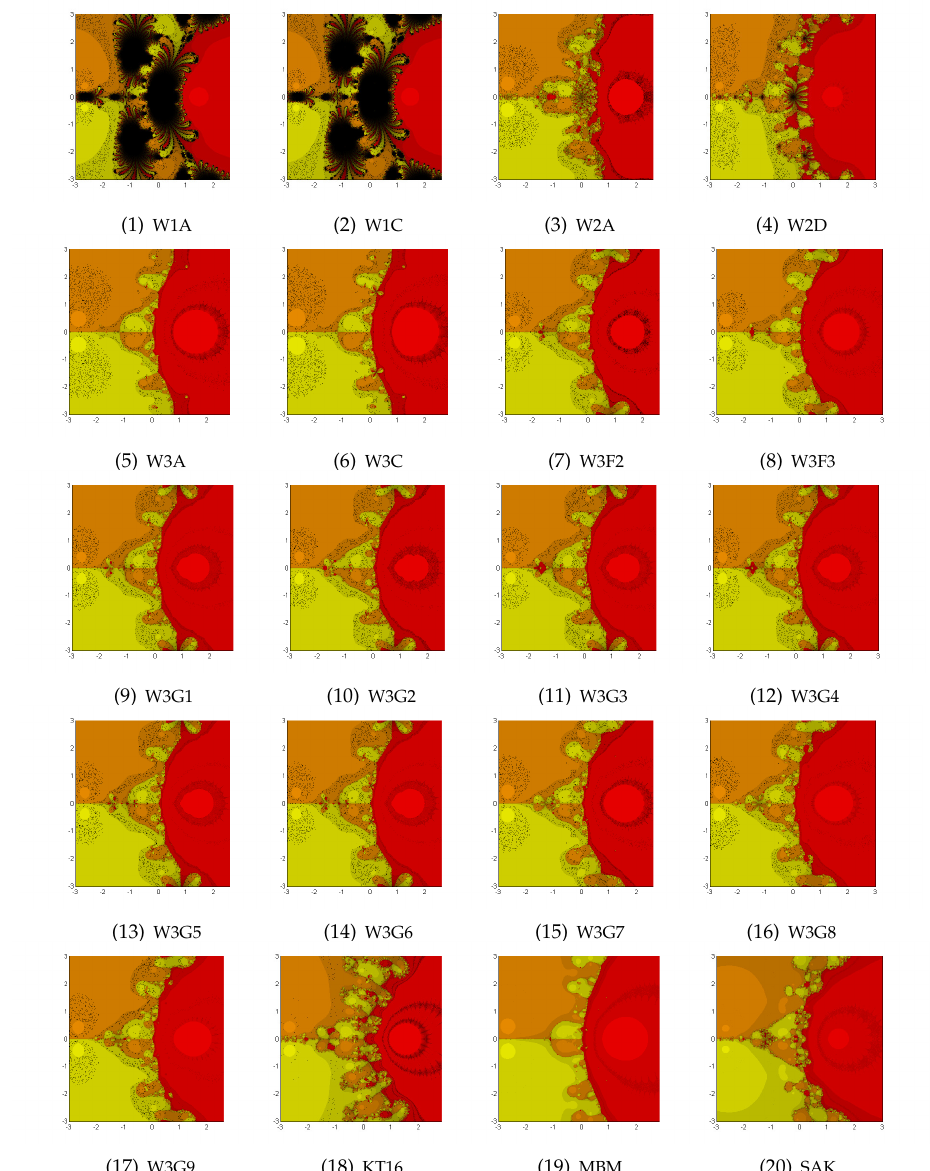
Figure 2. The top row for W1A (left), W1C (center left), W2A (center right) and W2D (right). The second row for W3A (left), W3C (center left), W3F2 (center right), and W3F3 (right). The third row for W3G1 (left), W3G2 (center left), W3G7 (center right), and W3G8 (right). The bottom row for W3G9 (left), KT16 (center left), MBM (center right) and SAK (right), for the roots of the polynomial equation ( z 3 + 4 z 2 − 10 )